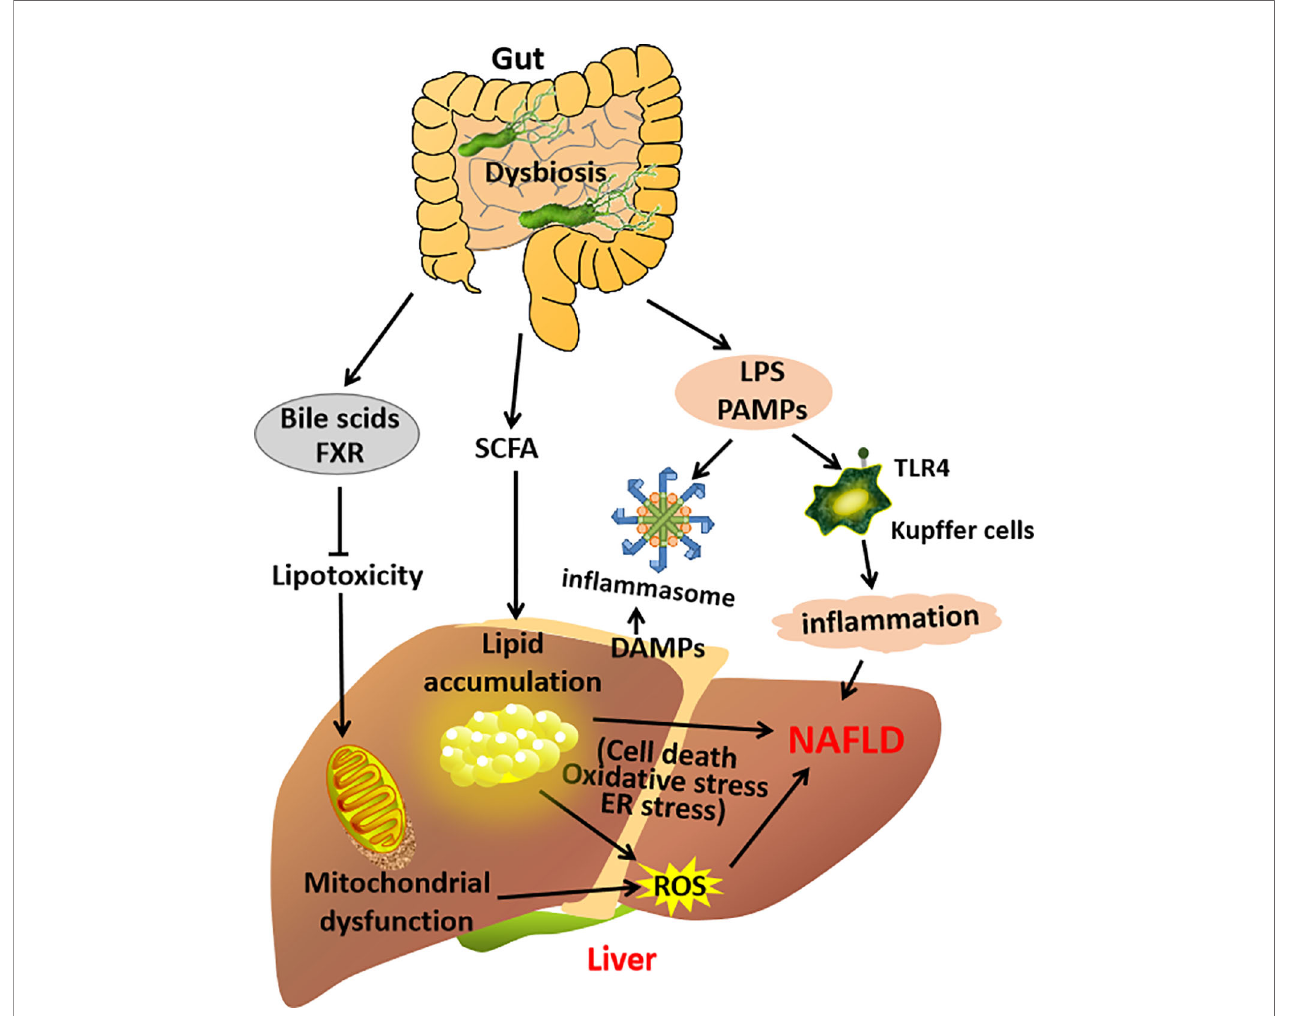
FIGURE 2 | A schematic diagram demonstrating the contribution of the gut – liver axis in NAFLD